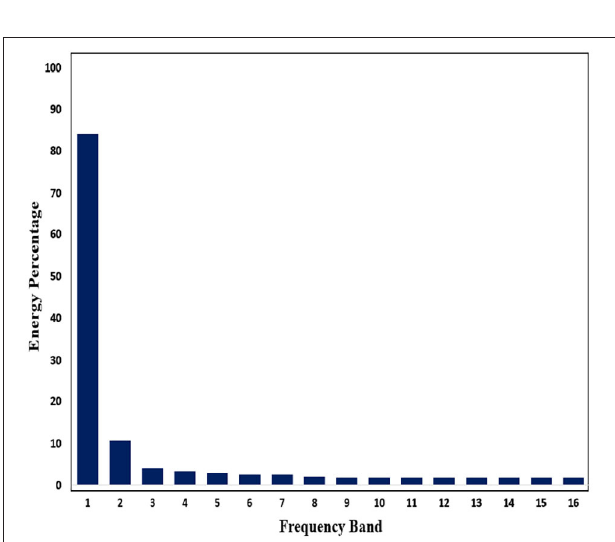
FIGURE 9 | Frequency-domain image of signal in inter-ictal is shown in figure.